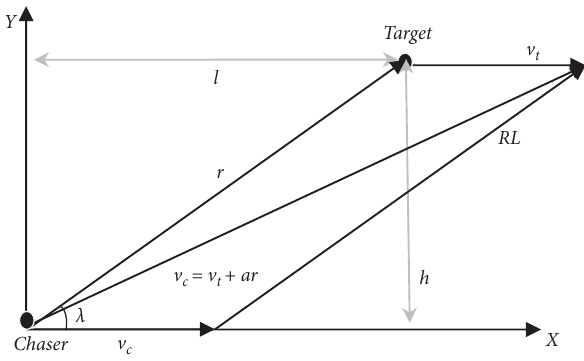
Figure 1: Construction of the rendezvous line